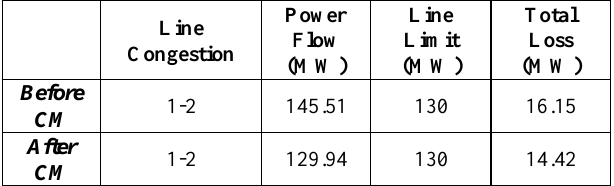
Table 8.Congested line details (Case 2)